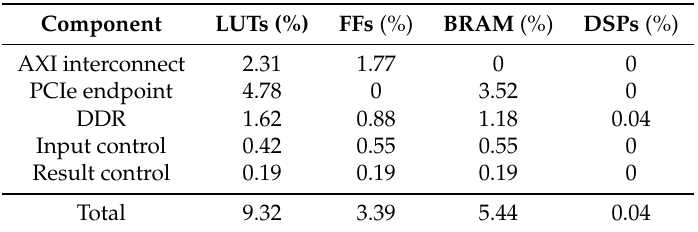
Table 6. Resource utilization of the system infrastructure (200 MHz, 512-bit, 64 PE).